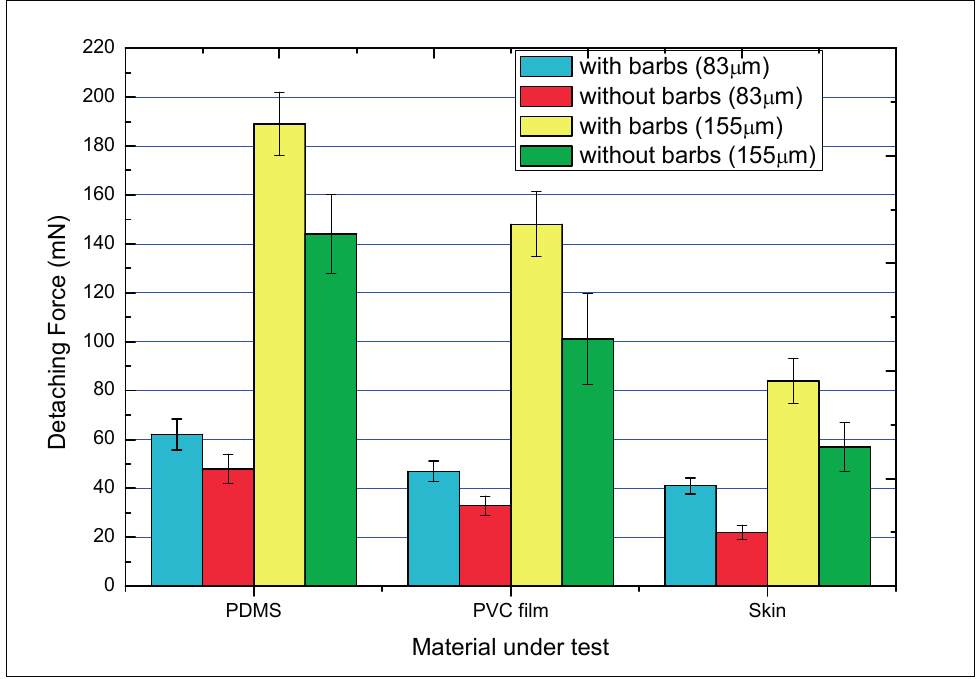
Figure 10. Measured detaching forces of different designs of